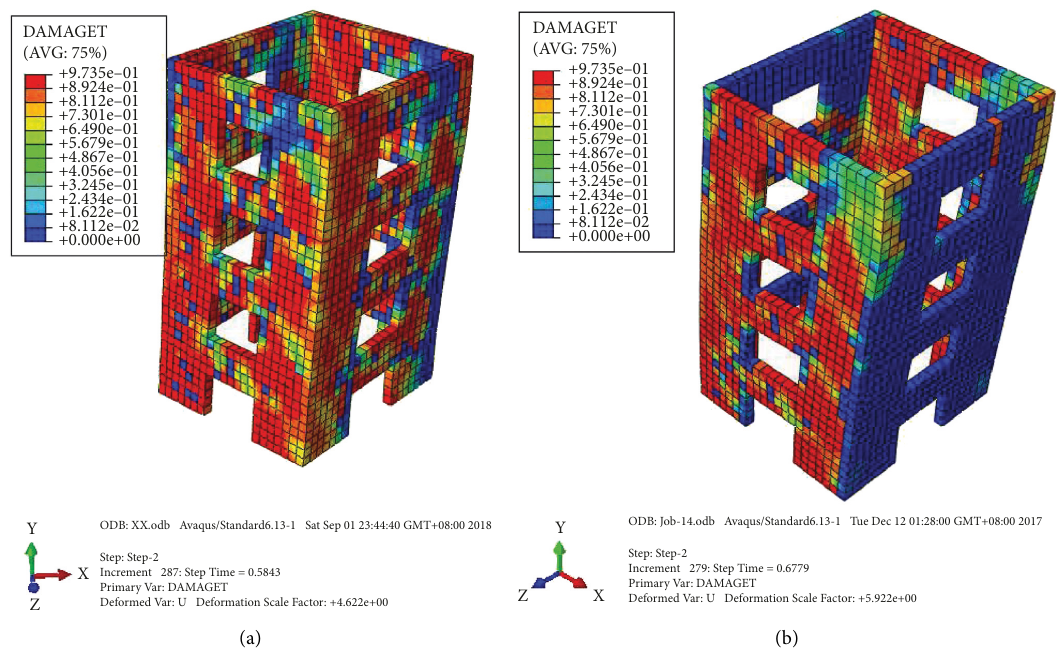
Figure 15: Tensile damage nephogram of concrete for SEDCCWs (FEA). (a) CW4X-D. (b) CW4X-1.